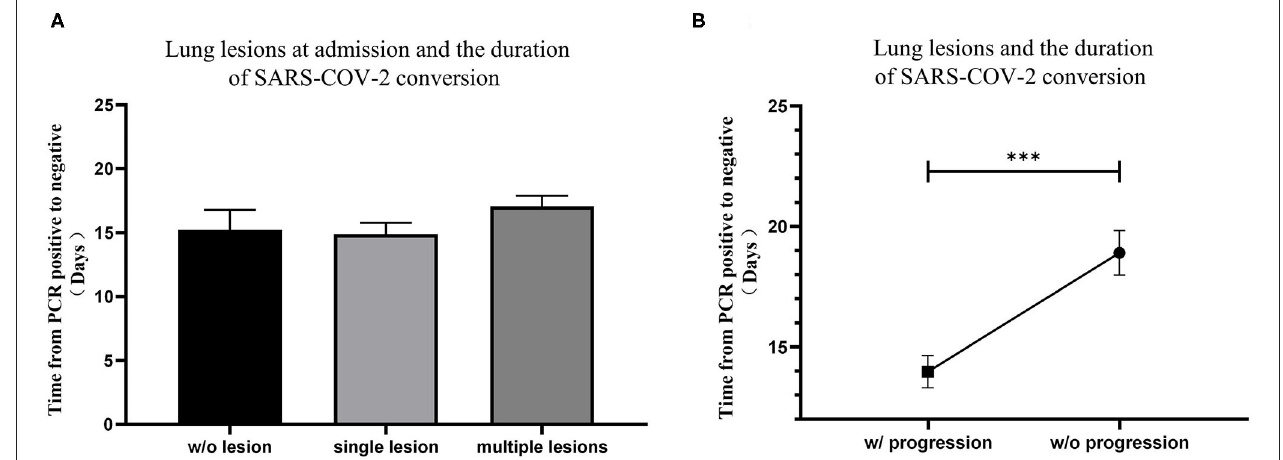
FIGURE 2 | The relationship between lung lesions measured by CT and the conversion time from real-time PCR (rtPCR) positive to negative. (A) The conversion time from rtPCR positive to negative of patients with no lung lesion, single lung lesion, and multiple lung lesions was compared. (B) The conversion time from rtPCR positive to negative of patients with and without progression of lung lesions was compared. Data are represented the mean ± SEM. The significance was determined as *** p < 0.001.